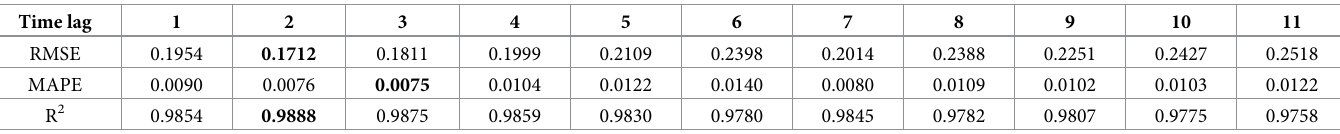
Table 1. Effects of different time lags on the prediction of back-propagation neural network models. Time